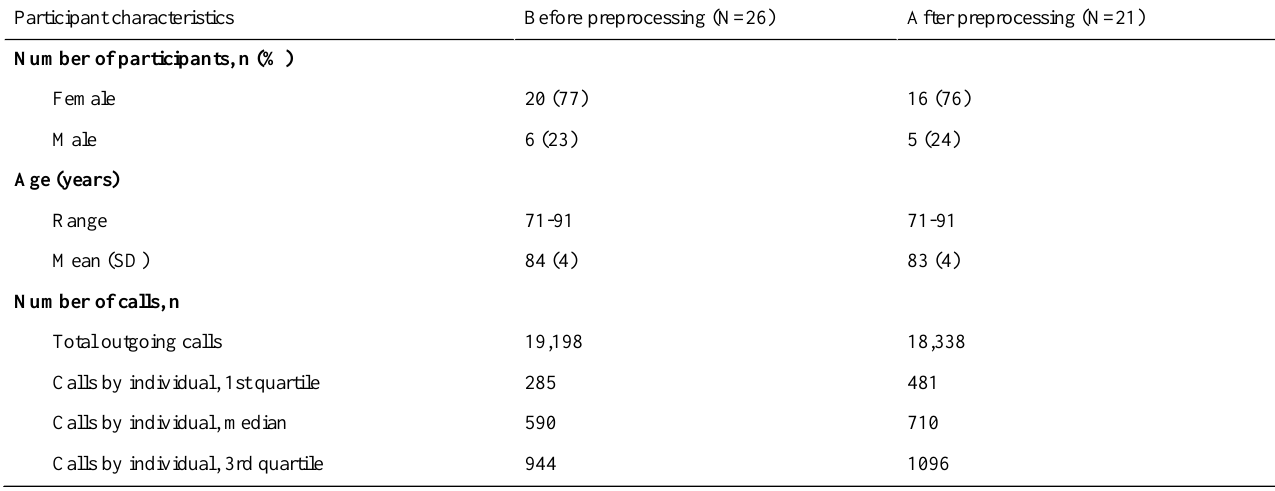
Table 1. Data set structure of call detail records before and after